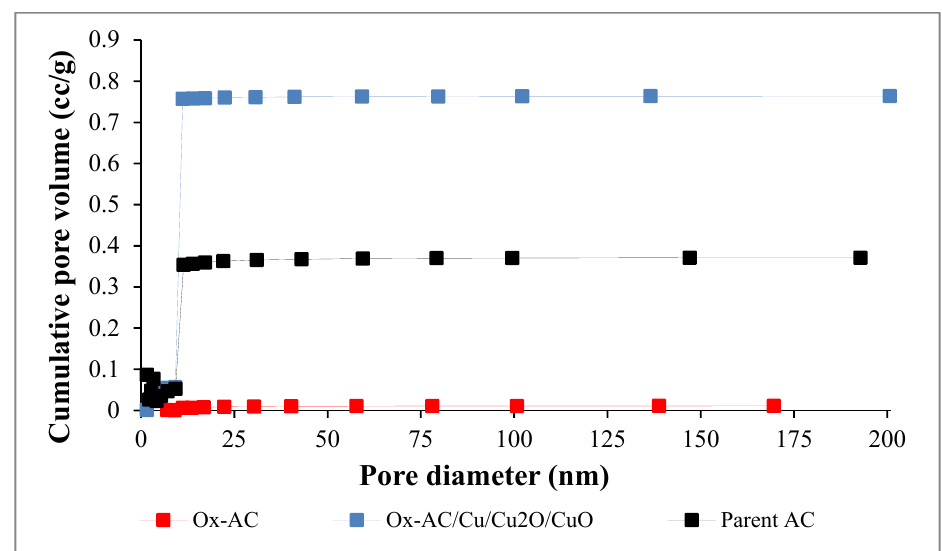
Figure 3. N 2 adsorption (unfilled points described by letter (A))-desorption (filled points described